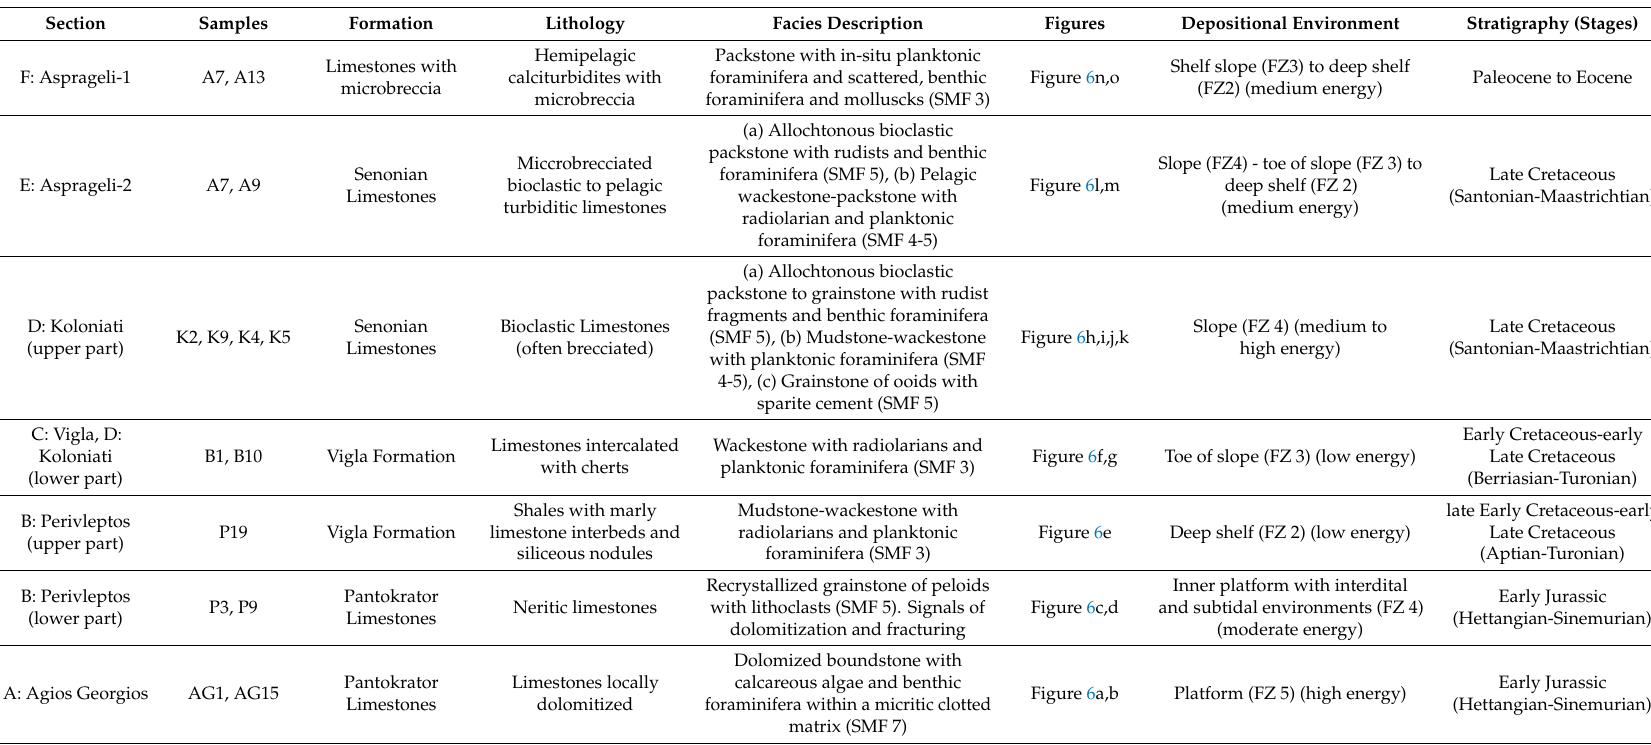
Table 3. Detailed description of representative thin sections, where sedimentary facies, lithology, formation, age, and the depositional environments of the studied deposits are